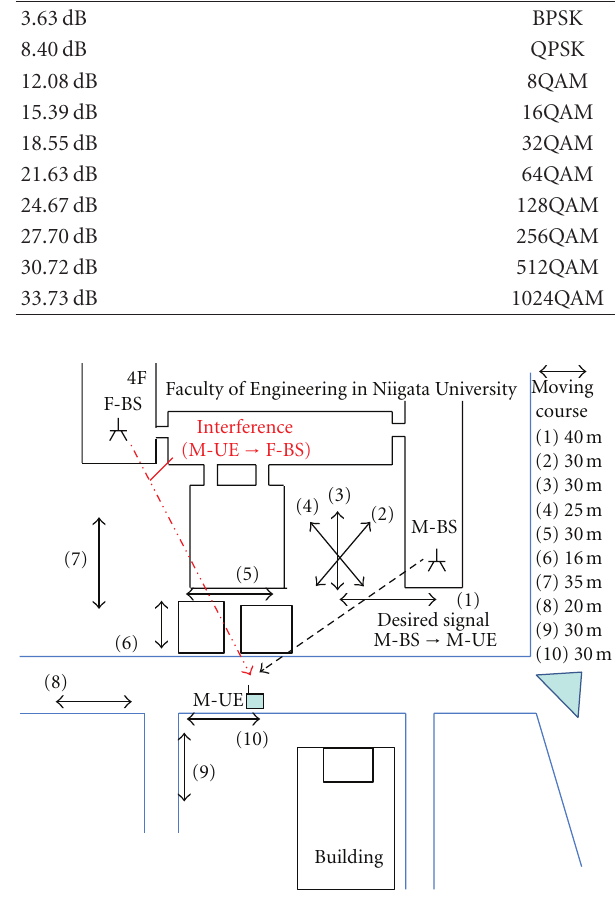
Figure 9: Measurement